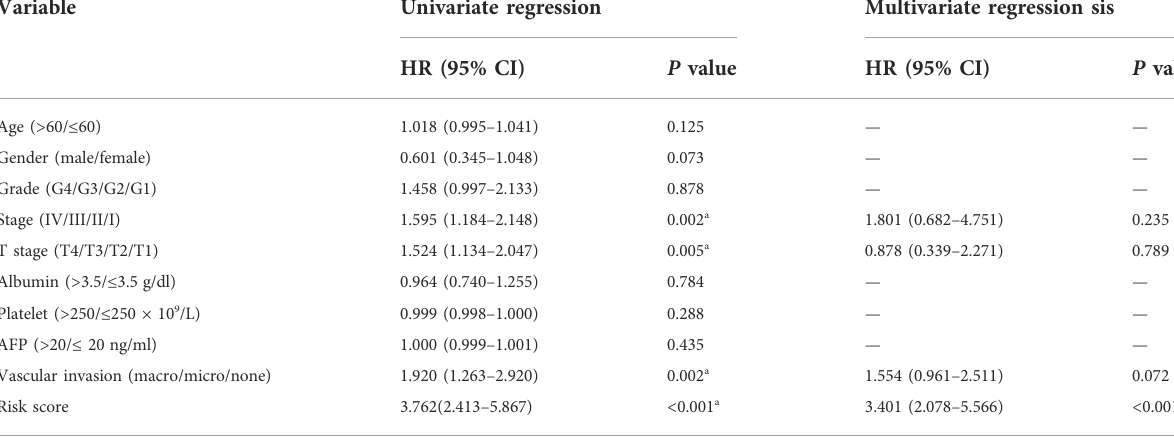
TABLE 1 Univariate and multivariate regression on OS-related clinicopathological features for TCGA-HCC cases. Variable